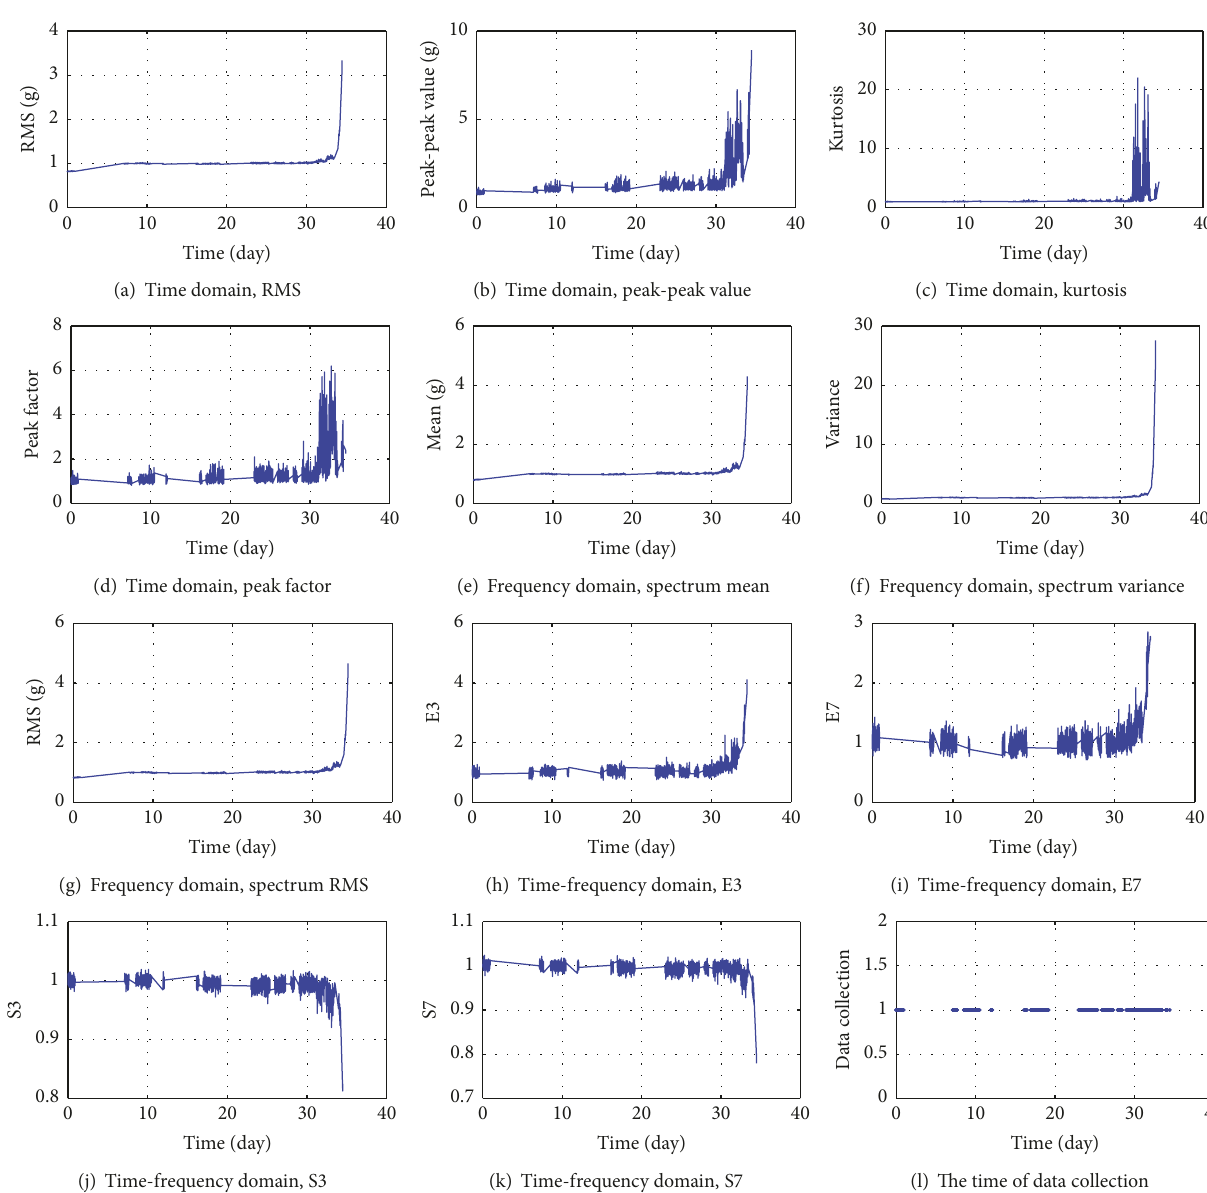
Figure 5: The 11 features extracted from the bearing full life